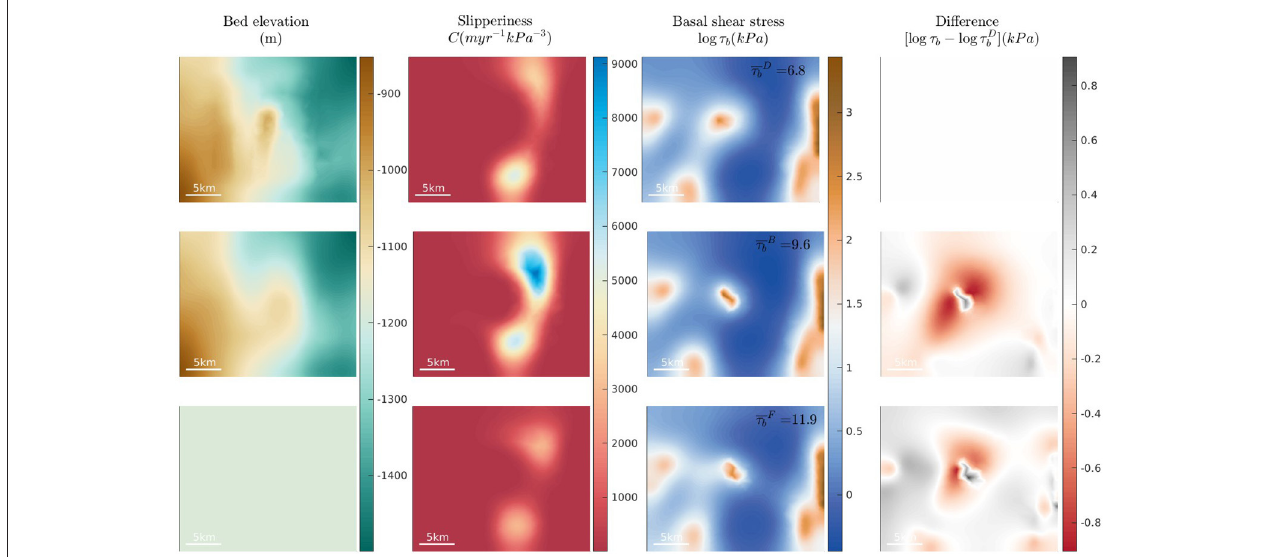
FIGURE 3 | The basal stress field from inversion of surface data over iSTARt1. Three results are shown using three different resolutions of bed elevation data (left column). Mean basal shear stress for each is given.